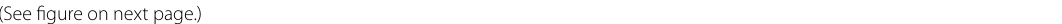
figure on next Fig. 6 MaR1-induced Akt activationin hepatic I/R injury is dependent on ALXR. a Akt and p-Akt protein levels in mice with thetreatment of PBS or MaR1 6 h after reperfusion. b The expression of Akt and p-Akt was evaluated by Western blot inthe liver of the indicated group. c Western blot showing the protein levels of total and phosphorylated Akt in micesubjected to vehicle or Akt inhibitor administration with or without thetreatment of MaR1. d RepresentativeWestern blotting and quantitative analyses revealing p-Akt protein expressionin the liver of indicated groups. e Serum ALT levels were measured in WT mice treated with vehicle or Akt inhibitorin the presence or absence of MaR1and harvested 6 h after I/R (n 5-6 = for I/Rgroup). f Representative H&Eimages (original magnification 20) of liver sections from WT mice treated withvehicle or Akt inhibitor in the × presence or absence of MaR1and harvested 6 hpost-reperfusion. g Percentages ofnecrotic areas are shown in the indicated I/R groups (n 3). h = Serum IL-6 levels of PBS- andMaR1-treated mice subjected to the vehicle or Akt inhibitor and harvested 6 hpost-reperfusion as analyzed by ELISA (n 5-6 for each group). i Cleaved-caspase 3 protein expressionof PBS- and MaR1-treated mice subjected to the vehicle or Akt inhibitor andliver = tissues harvested 6 h after I/R as analyzed by Western blotting. Data arepresented as means SEM. * P < 0.05, **P < 0.01, *** P < ±